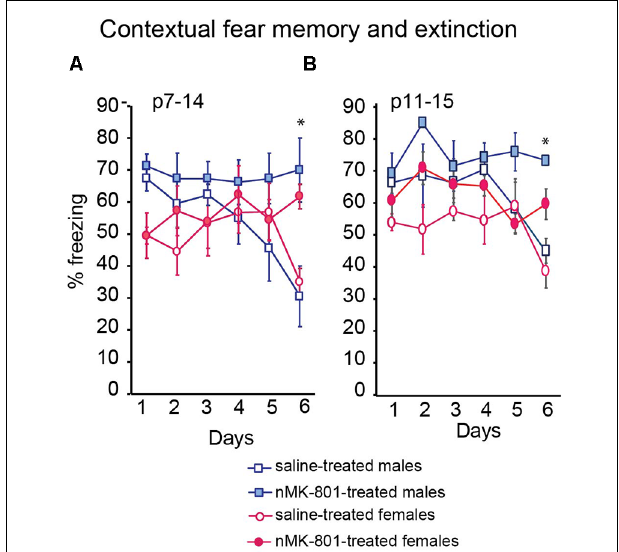
FIGURE 4 | Effects of neonatal treatment with MK-801 at p7–14 (A) ( n = 15) and p11–15 (B) ( n = 15) compared to the respective saline-treated mice ( n = 13 for each saline-treated group) on contextual fear memory and extinction. Open bars represent saline-treated mice, while colored bars represent the nMK-801-treated mice. (A) Repeated measures ANOVA analysis revealed day ∗ treatment interaction ( F (1,26) = 7.552, p = 0.014). Per-day two-way ANOVA analyses showed that there was an effect of sex on day 1, no other effects on day 2–5 and a treatment effect on day 6 ( F (1,26) = 18.412, p = 0.001), but not an effect of sex or sex ∗ treatment interaction (p7–14 model). (B) Repeated measures ANOVA analysis revealed day ∗ treatment interaction ( F (1,26) = 6.552, p = 0.016). Per-day two-way ANOVA analyses showed that there was an effect of sex on day1, no other effects on day 2–5 and a treatment effect on day 6 ( F (1,26) = 15.334, p = 0.001), but not an effect of sex or sex ∗ treatment interaction (p11–15 model). ∗ p <